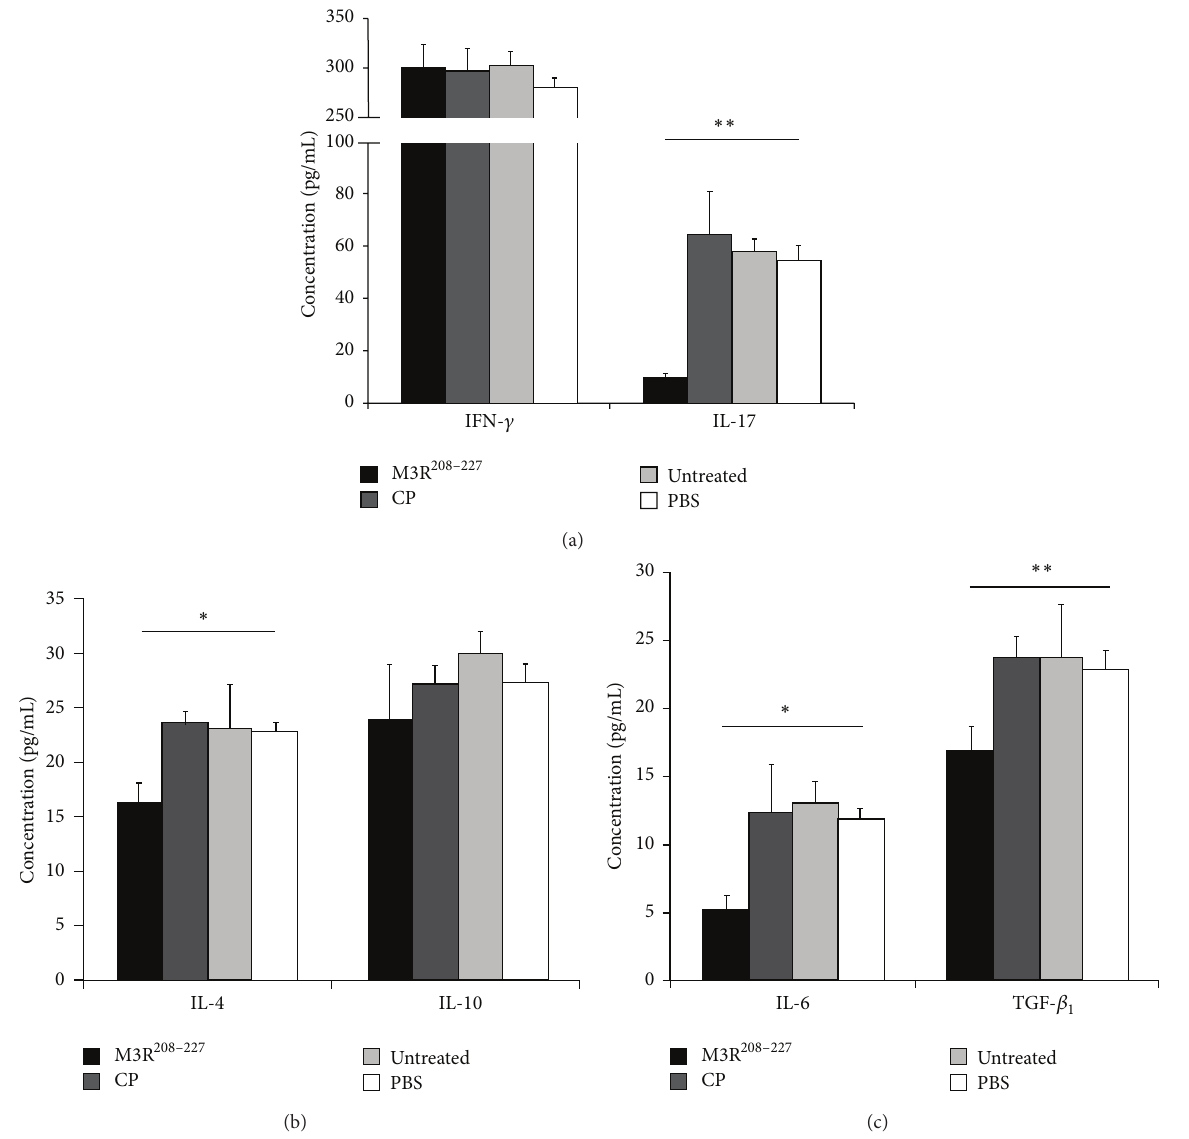
Figure3:ThesecretionsofIL-17,IL-4,IL-6,andTGF- 𝛽 1 weredecreasedinthecellsupernatantsfollowingincubationwithM3R 208−227 peptide. Spleens were isolated from the NOD/LtJ mice immunized with the M3R 208−227 peptide and the spleen cells were pooled. The homogenates were adjusted to 1 × 10 6 cells/mL and incubated with M3R 208−227 (black bar), CP (charcoal gray bar), or PBS (white bar). Untreated spleen cells servedasanadditionalcontrol(lightgraybar).Cellsupernatantswerecollectedafter48hoursofculture,andthecytokineconcentrationswere measured using ELISA kits. (a) The results indicated that the secretion of IL-17 was significantly reduced in the supernatants of cells that had been cocultured with the M3R 208−227 peptide in comparison to those cocultured with CP and PBS or left untreated ( ∗∗ 𝑃 < 0.005 ), although no significantdecreaseinIFN- 𝛾 wasobserved( 𝑃 > 0.05 ).(b)TheseresultsshowedthatthesecretionofIL-4wasalsosignificantlydecreasedinthe supernatantsofcellscoculturedwithM3R 208−227 ascomparedtothosecoculturedwithCPandPBSorleftuntreated( ∗ 𝑃 < 0.05 ).Nosignificant decrease in IL-10 secretion was observed ( 𝑃 > 0.05 ). (c) The results showed that the secretion of IL-6 and TGF- 𝛽 1 was significantly decreased in the supernatants of cells cocultured with M3R 208−227 as compared to those cocultured with CP and PBS or left untreated ( ∗ 𝑃 < 0.05 ; ∗∗ 𝑃 < 0.005